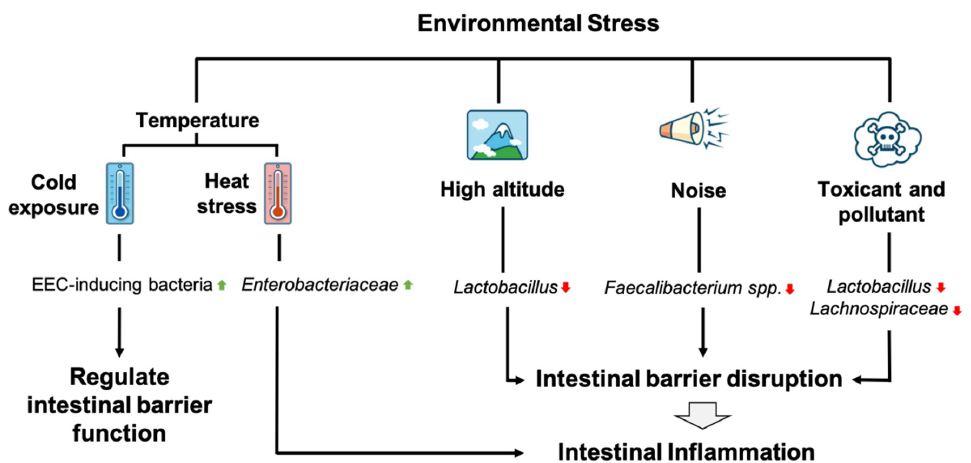
Figure 2. Alteration of gut microbiota by environmental stress impacts intestinal inflammation. Cold exposure changes the gut microbiota, which may be associated with the increase of EEC-inducing bacteria population and influence intestinal barrier function. Meanwhile, heat stress increases the population of Enterobactericeae and intestinal barrier disruption leading to intestinal inflammation. Other stressors such as high altitude, noise, pollutant and toxicant reduce anti-inflammatory gut microbiota— including Lactobacillus , Faecalibacterium , and Lachnospiraceae —increase the disruption of intestinal barrier, resulting in intestinal inflammation.